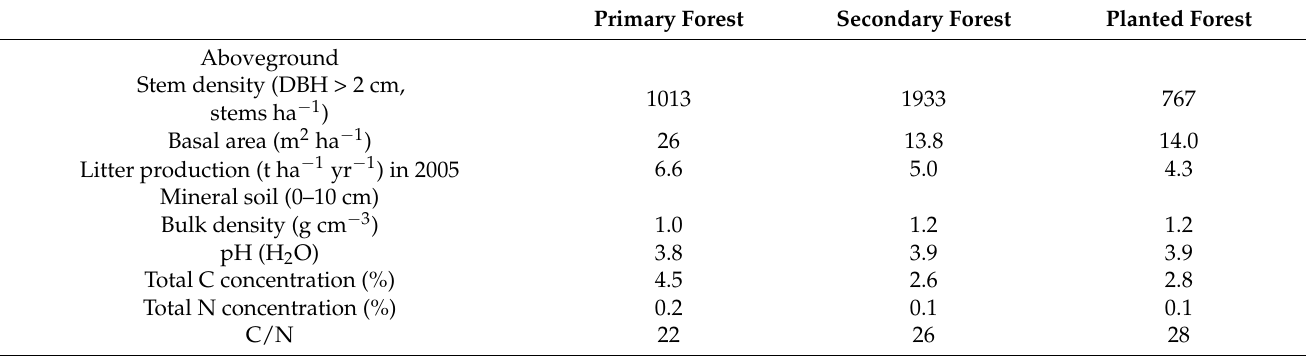
Table 1. Characteristics of the three study